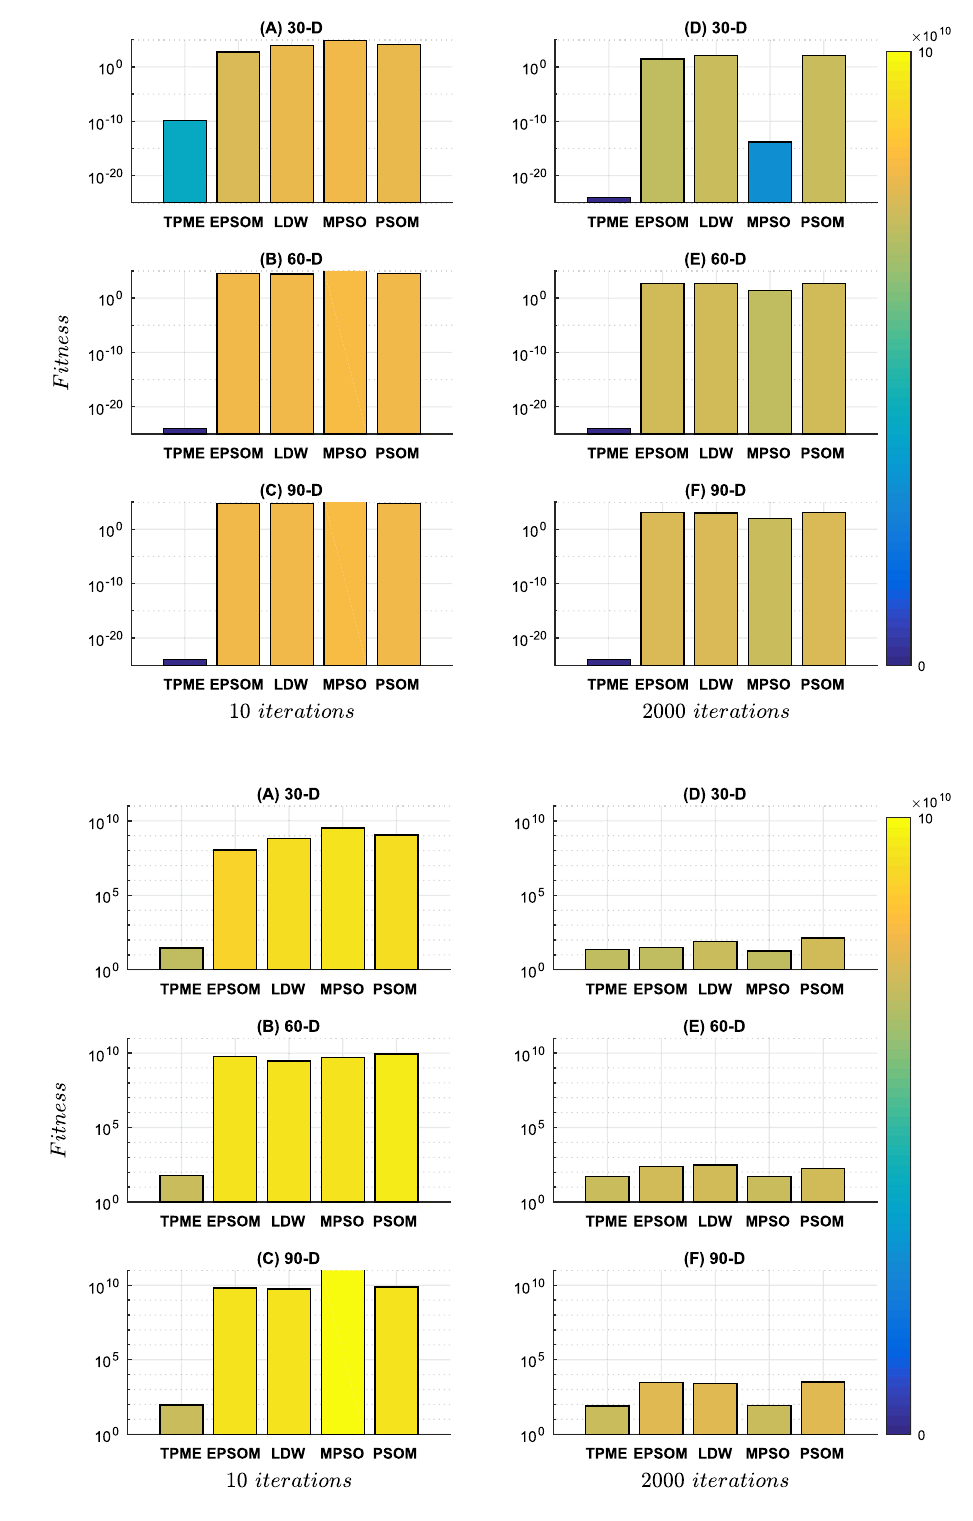
Fig. 9 Fitness performance of PSO variants on 30, 60 and 90 dimensional Rastrig function (F9) after 10 and 2000 iterations